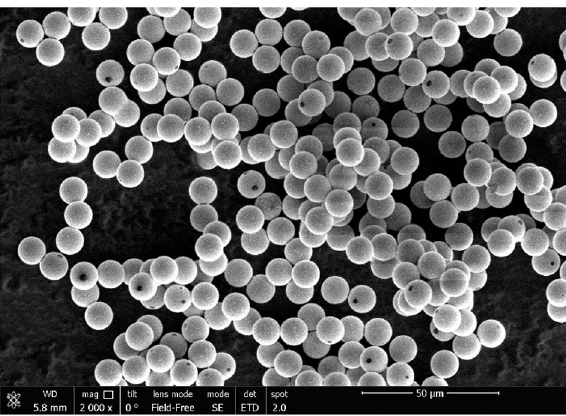
Figure 2. Scanning electron microscopy photograph of a metal-coated